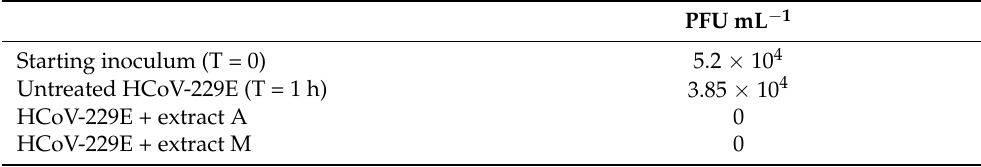
Table 2. Results of plaque assay of treated or untreated HCoV-229E on human MRC-5 fibroblast cells. Treatment of the virus was performed using N. oleoabundans extracts obtained from autotrophic (A) or mixotrophic (M) cultures. Count was performed after five days of incubation.